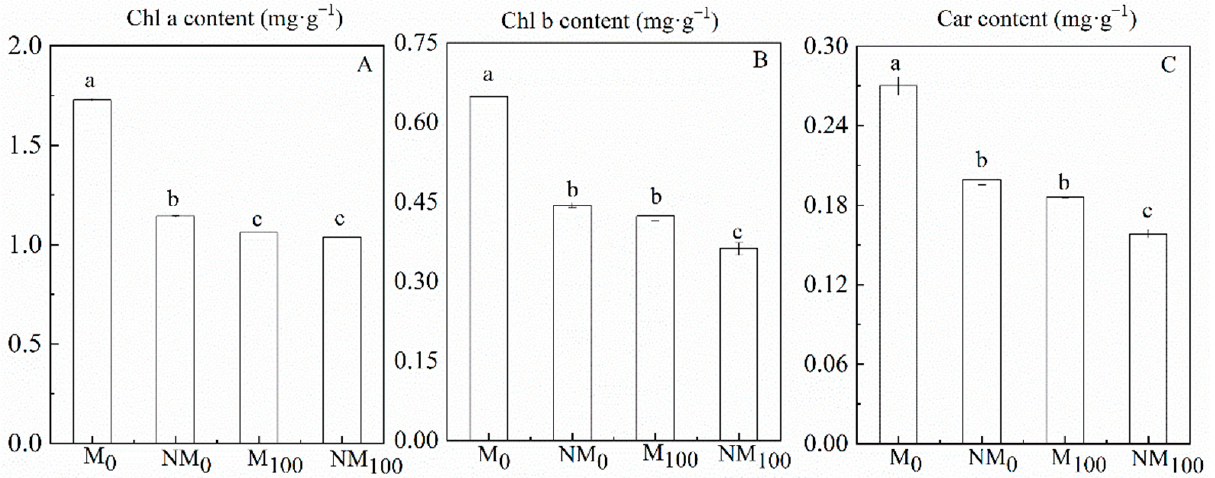
Figure 2. Changes in the contents of chlorophyll a (Chl a, ( A )), chlorophyll b (Chl b, ( B )), and carotenoids (Car, ( C )) in leaves of Neva irrigated with or without magnetized water following exposure to 0 or 100 µ mol · L − 1 cadmium stress. Values are the means ± SE of at least three replicates. Different lowercase letters indicate significant differences among the four treatments at the 0.05 level.